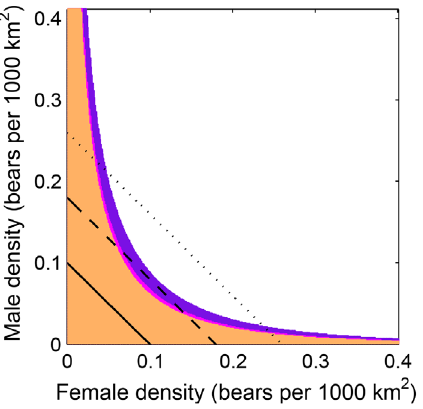
Figure 2. The mate-finding Allee threshold in polar bears. Three initial age-structures are considered, corresponding to an ‘‘old’’, an ‘‘intermediate’’ and a ‘‘young’’ population. In the old population, all females and males are sexually mature adults (i.e., in stages 4 and 10, cf. Fig. 1) at the beginning of the projection, whereas in the young population all bears are 2-year-old subadults (i.e., in stages 1 and 7). In the intermediate population, females and males are distributed between age classes (stages 1 to 4 for females, and 7–10 for males) according to proportions that would be obtained under a stable-stage distribution. In all scenarios, adult females are taken to be without dependent offspring at the beginning of the projection. Scenarios marked orange lead to extirpation for all three initial age-structures; scenarios marked pink lead to extirpation in the young and intermediate population, but not in the old population; purple marks scenarios that lead to extirpation in the young population only. The solid, dashed, and dotted lines correspond to polar bear populations of fixed densities 0.10, 0.18 and 0.26 bears per 1000 km 2 , respectively, illustrating (i) that a population will always become extirpated at extremely low densities regardless of sex ratio or age-structure (solid line), (ii) that at somewhat higher densities a population may or may not persist at balanced sex ratios depending on its age-structure, but always becomes extirpated with biased sex ratios (dashed line), and (iii) that at even higher densities a population is always expected to persist regardless of age-structure, unless the sex ratio is extremely biased (dotted line).